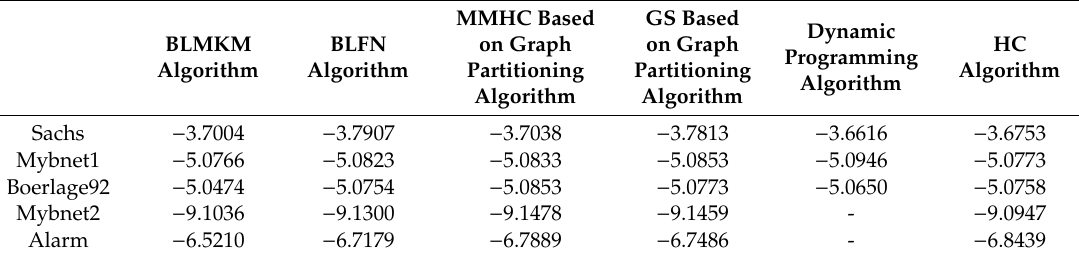
Table 3. The BIC score of six